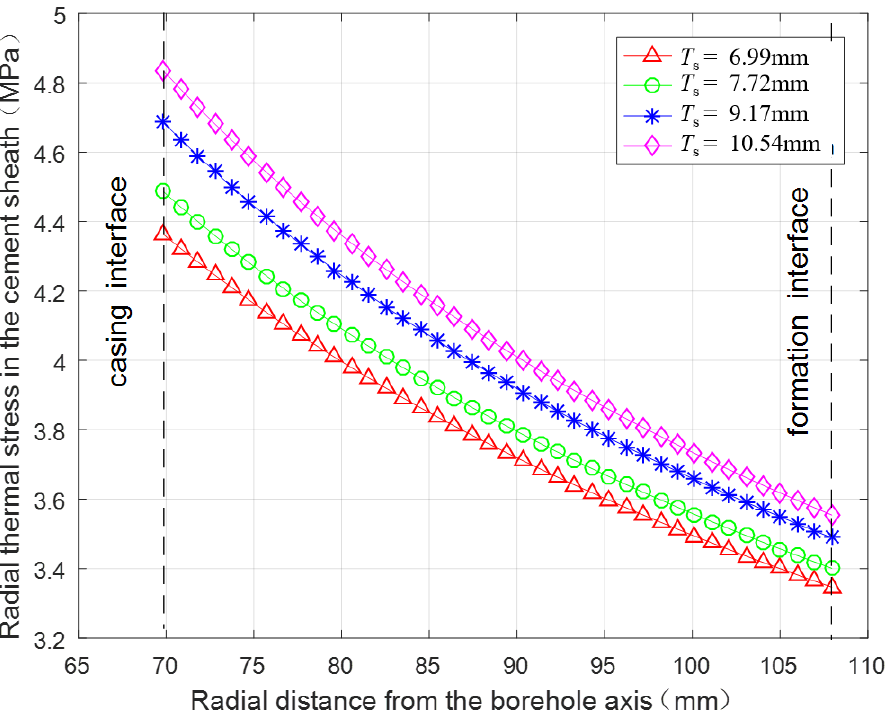
Figure 4. Radial distribution of the radial thermal stress in the cement sheath under different wall thicknesses of the casing.